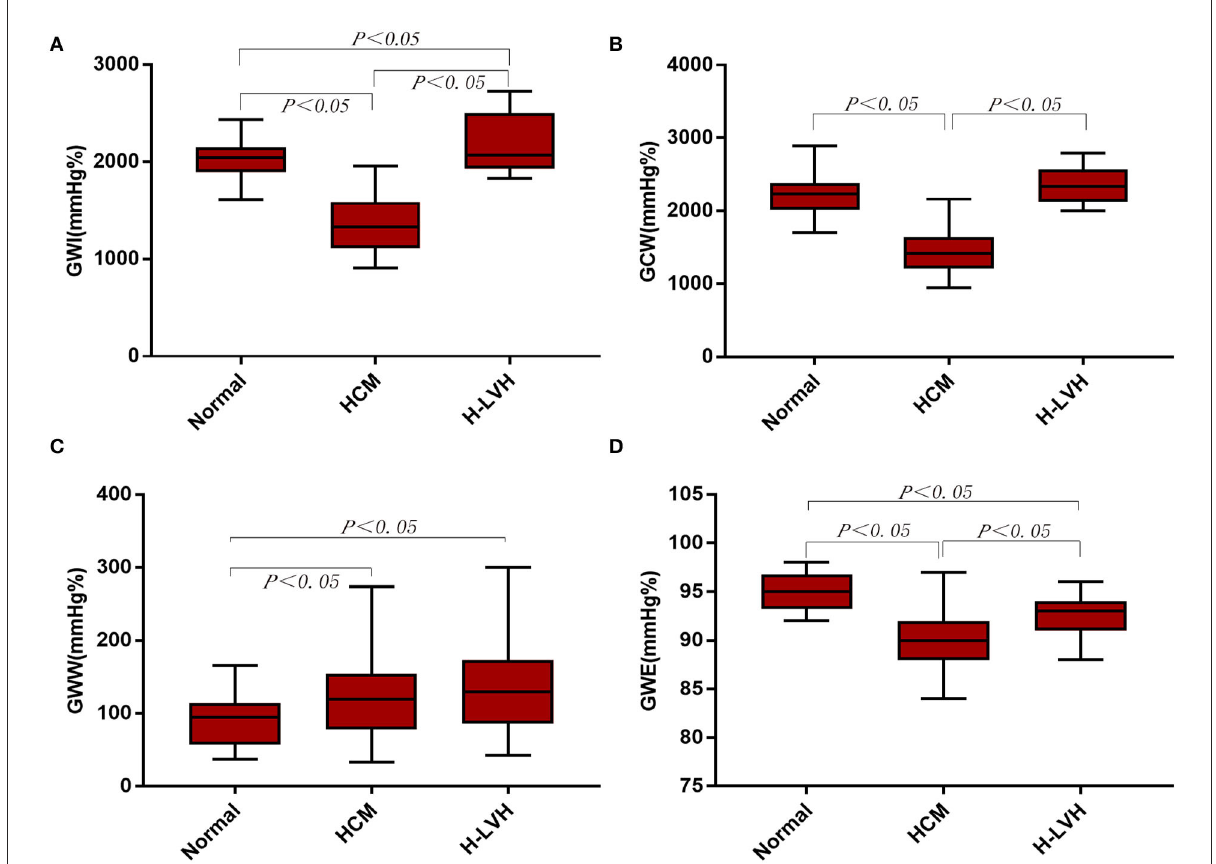
FIGURE2 Left ventricular myocardial work in the control, HCM, and H-LVH groups. (A) GWI (global work index); (B) GCW (global constructive work); (C) GWW (global wasted work); (D) GWE (global work